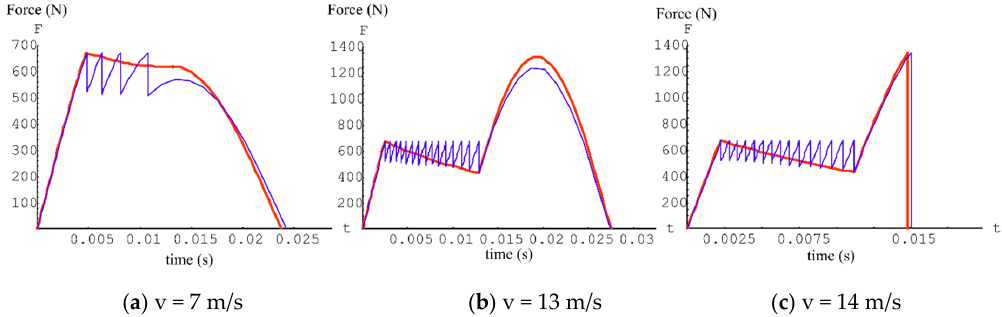
Figure 7. Forced responses at various initial velocities (v = 7 m/s, 13 m/s, 14 m/s). Number of segments = 15, red line: approximate solution, blue line: exact solution.